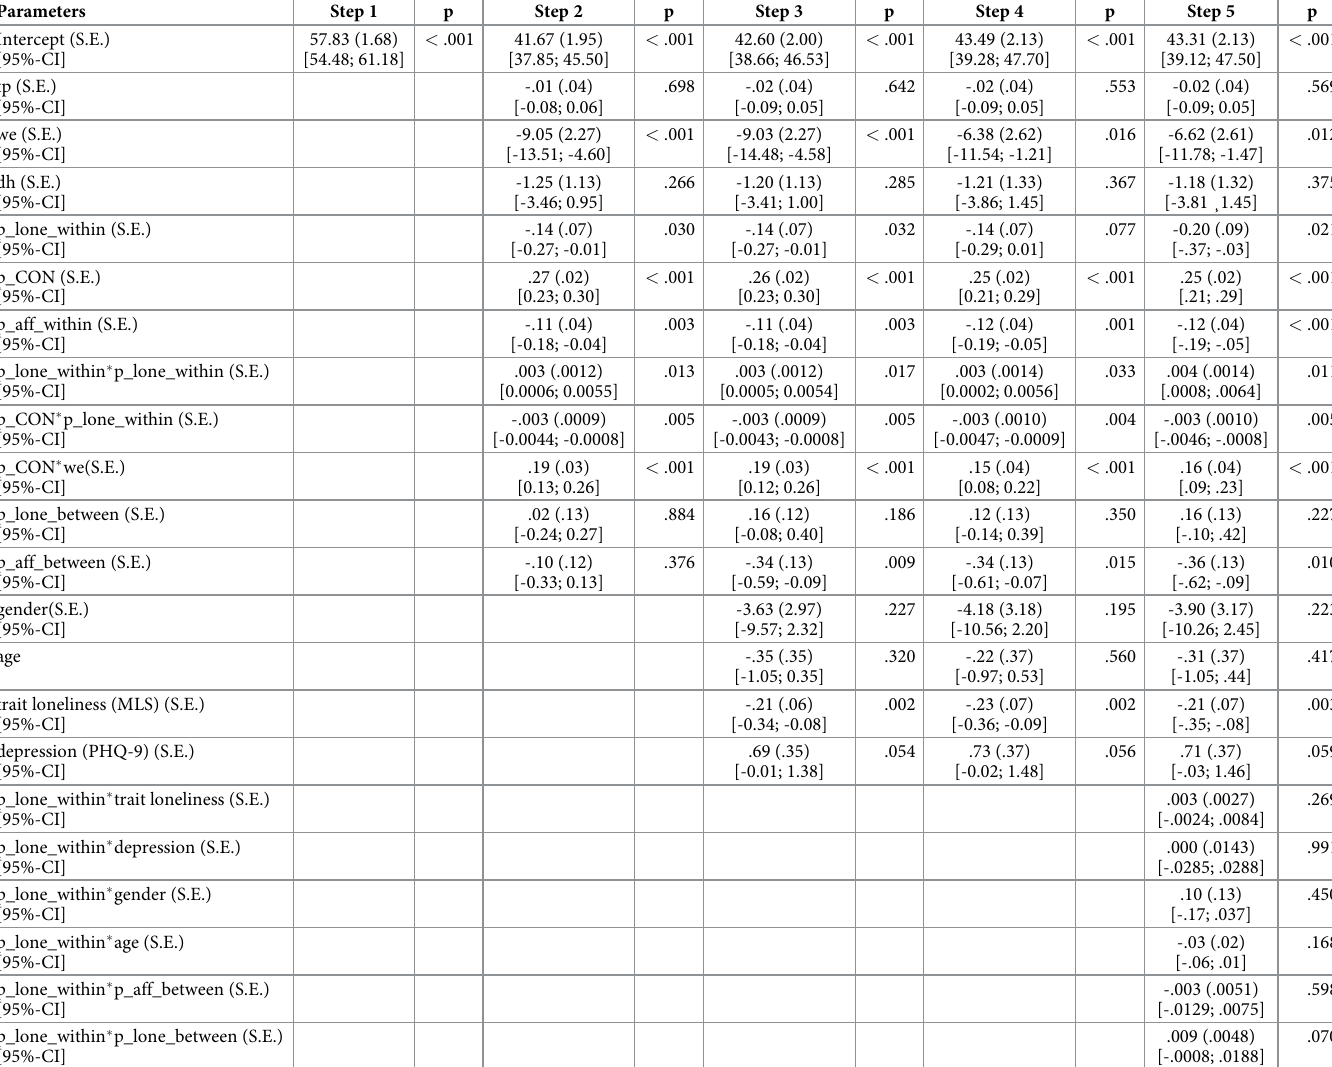
Table 6. Model summary table with a display of the estimated fixed effects. Effects are expressed as unstandardized regression